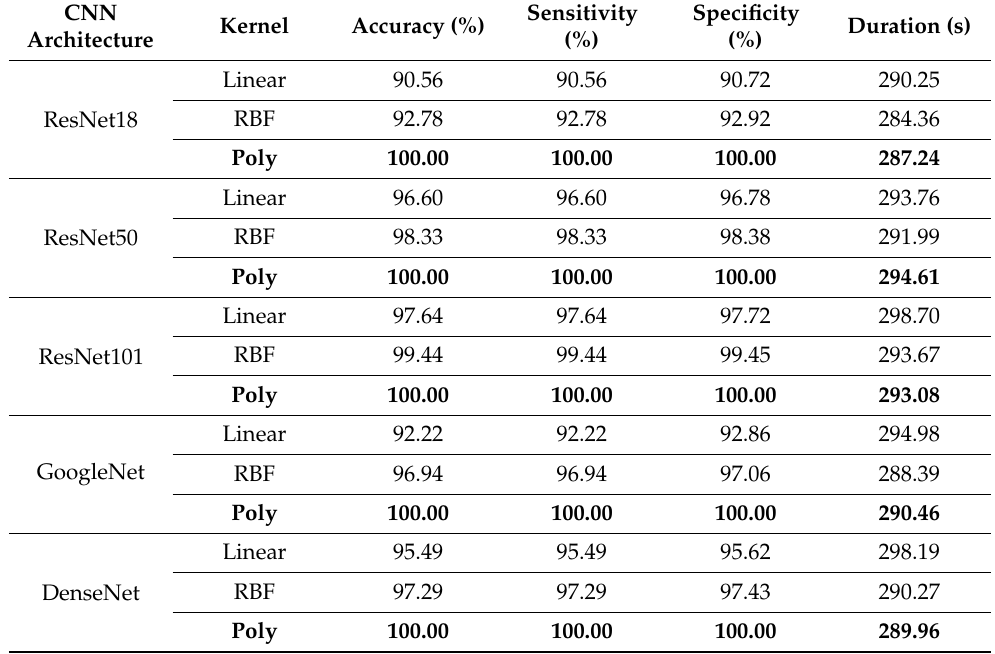
Table 3. Results of Experiment on Two-Class MESSIDOR Dataset.